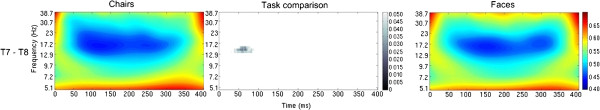
Mann–Whitney task comparison of interhemispheric coherence for the ASC group (uncorrected P-values). The colored graphs represent values of wavelet coherence for the ASC group, for every time-frequency point, for each task (Chairs: left column, Faces: right column) and for electrode pair T7-T8; areas in blue represent regions of low coherence in the time-frequency spectrum, while areas in red represent regions of high coherence. The graph in the middle represents the statistical task comparison for electrode pair T7-T8; areas shaded gray represent regions of the time-frequency spectrum where there is a significant decrease of coherence for the chairs task when compared to the faces task, at Puncorrected <0.05. For the ASC group, no areas of significant differences in coherence between tasks were found for any other electrode pairs.